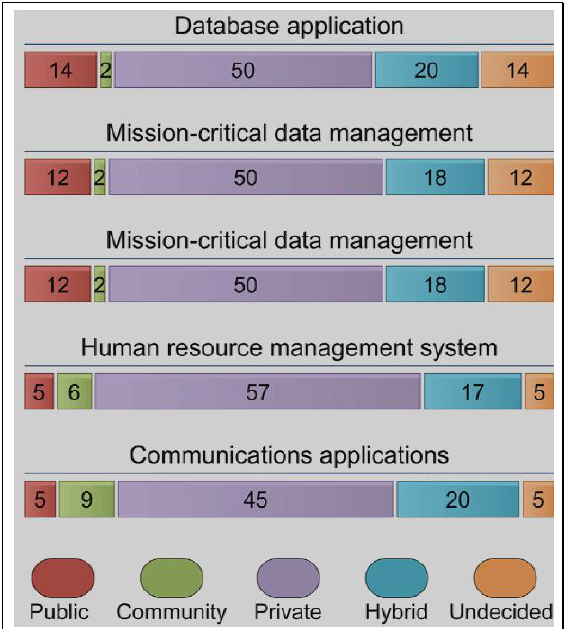
Figure 3 Cloud Computing Concerns. Adapted from (Davis, 2010)